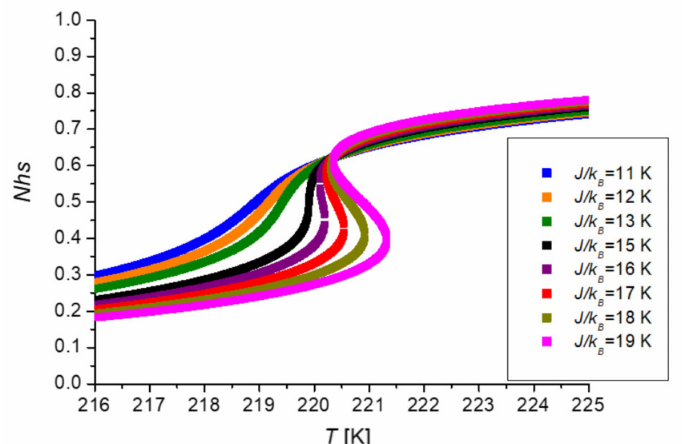
Figure 3. Thermal evolution of the HS fraction in a SCO system with a size of 6 × 6 for different values of the average interaction parameter J / k B : J / k B = 19 K (magenta square), J / k B = 18 K (dark yellow square), J / k B = 17 K (red square), J / k B = 16 K (purple square), J / k B = 15 K (black square), J / k B = 13 K (green square), J / k B = 12 K (orange square) and J / k B = 11 K (blue square). The computational parameters are: ∆ / k B = 1300 K, G / k B = 172.2 K, x = J HH / J LL = 0.4 and ln( g ) =